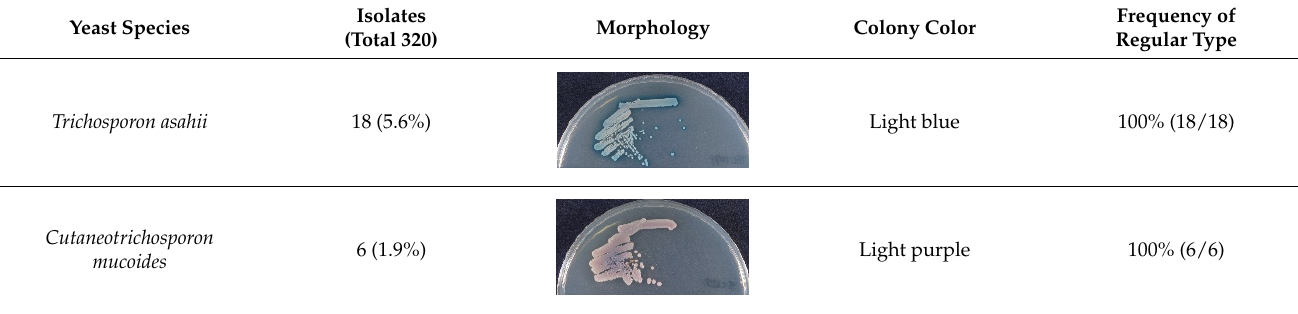
Table 4. Appearance of non- Candida species 1 in the oral samples on CHROMagar Candida plates.